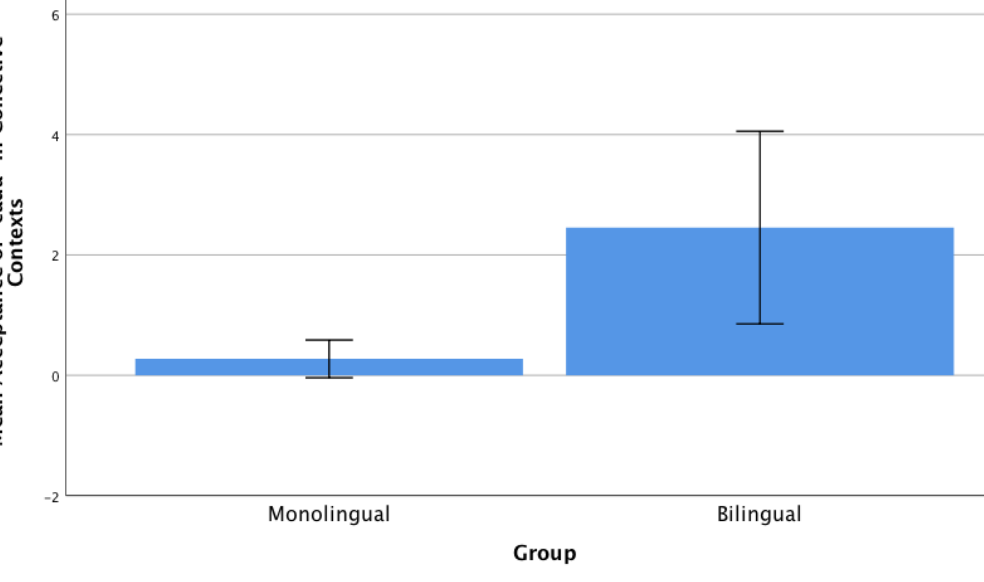
Figure 8. Mean Acceptance of cada ‘each’ Distributive Sentences in Collective